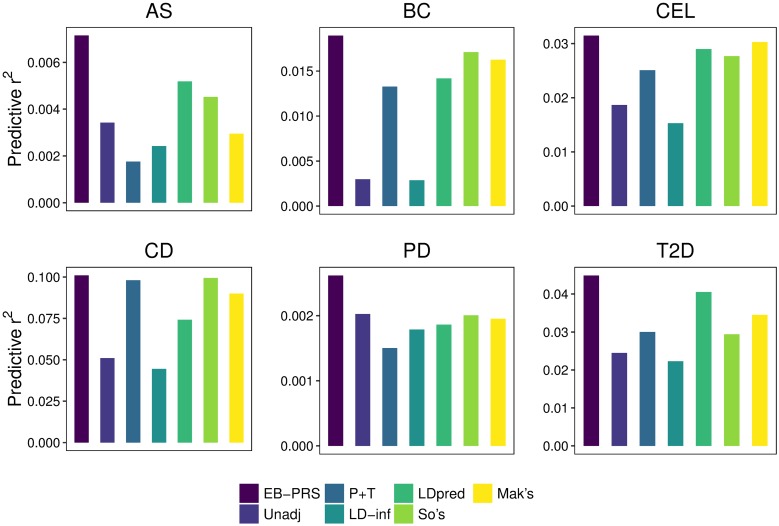
Comparisons of predictve r2 between EB-PRS and six other methods PRS on real data from six diseases.